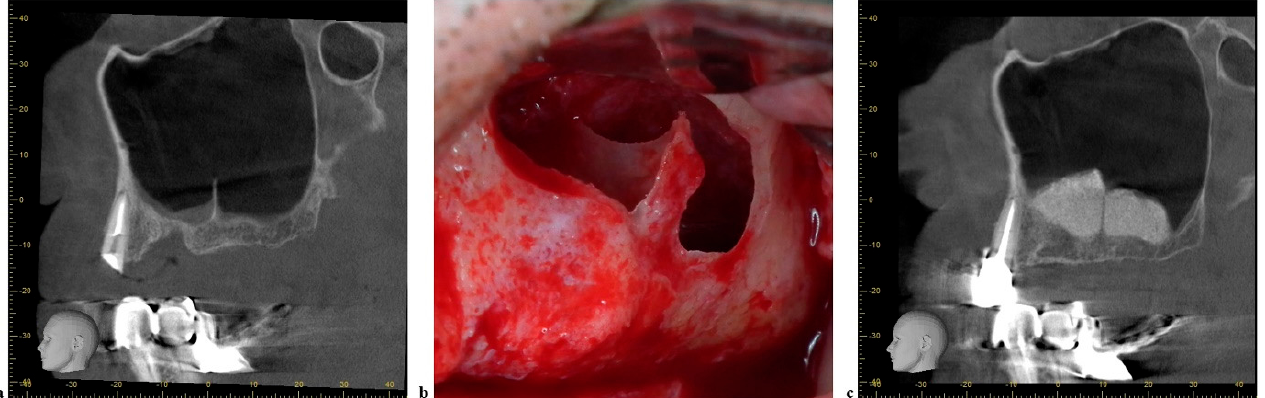
Figure 2. Management of medio − lateral septa. ( a ) CBCT sagittal view of the left maxilla with a medio − lateral oriented septum. ( b ) One window with a modified design of the osteotomy. ( c ) CBCT sagittal view after maxillary sinus floor augmentation.